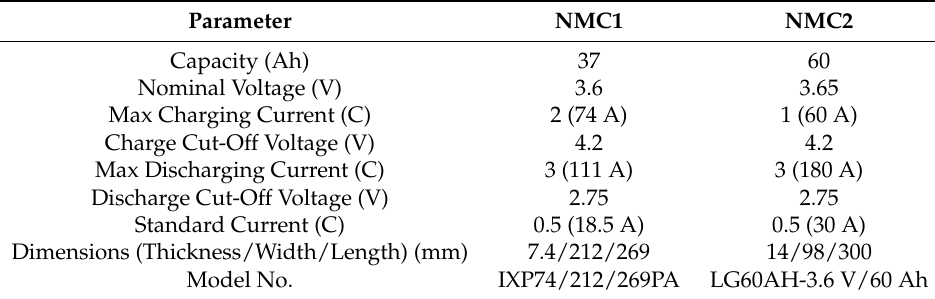
Table 1. Specification of tested